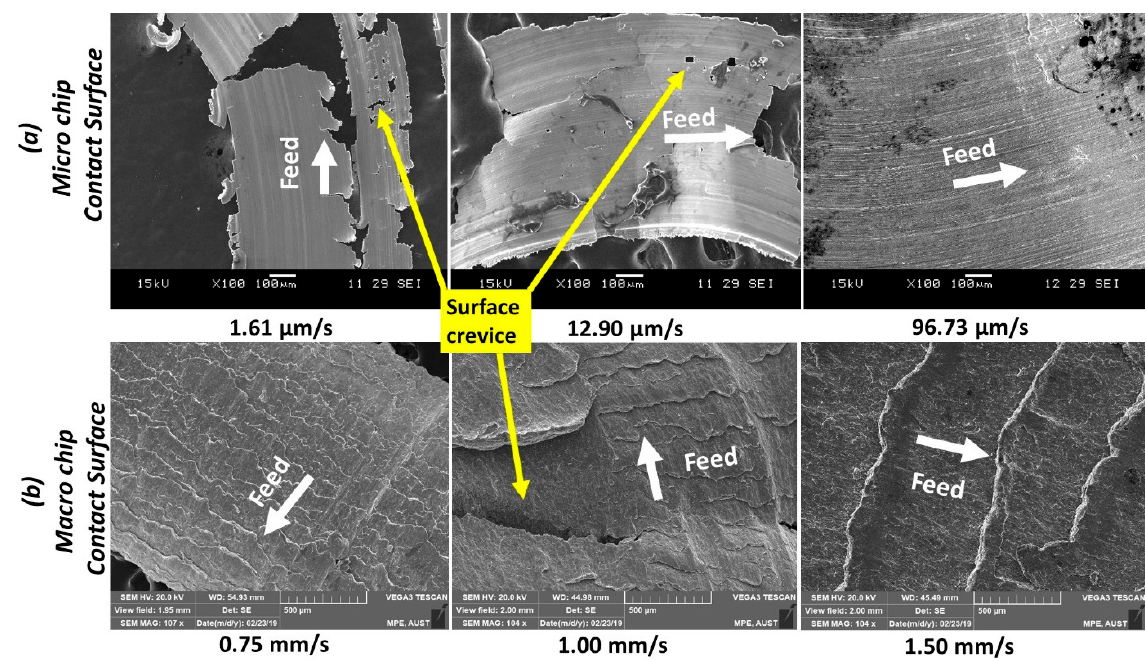
Figure 15. Morphology of contact surface of Al alloy chip produced in ( a ) micro machining ( b ) macro machining.